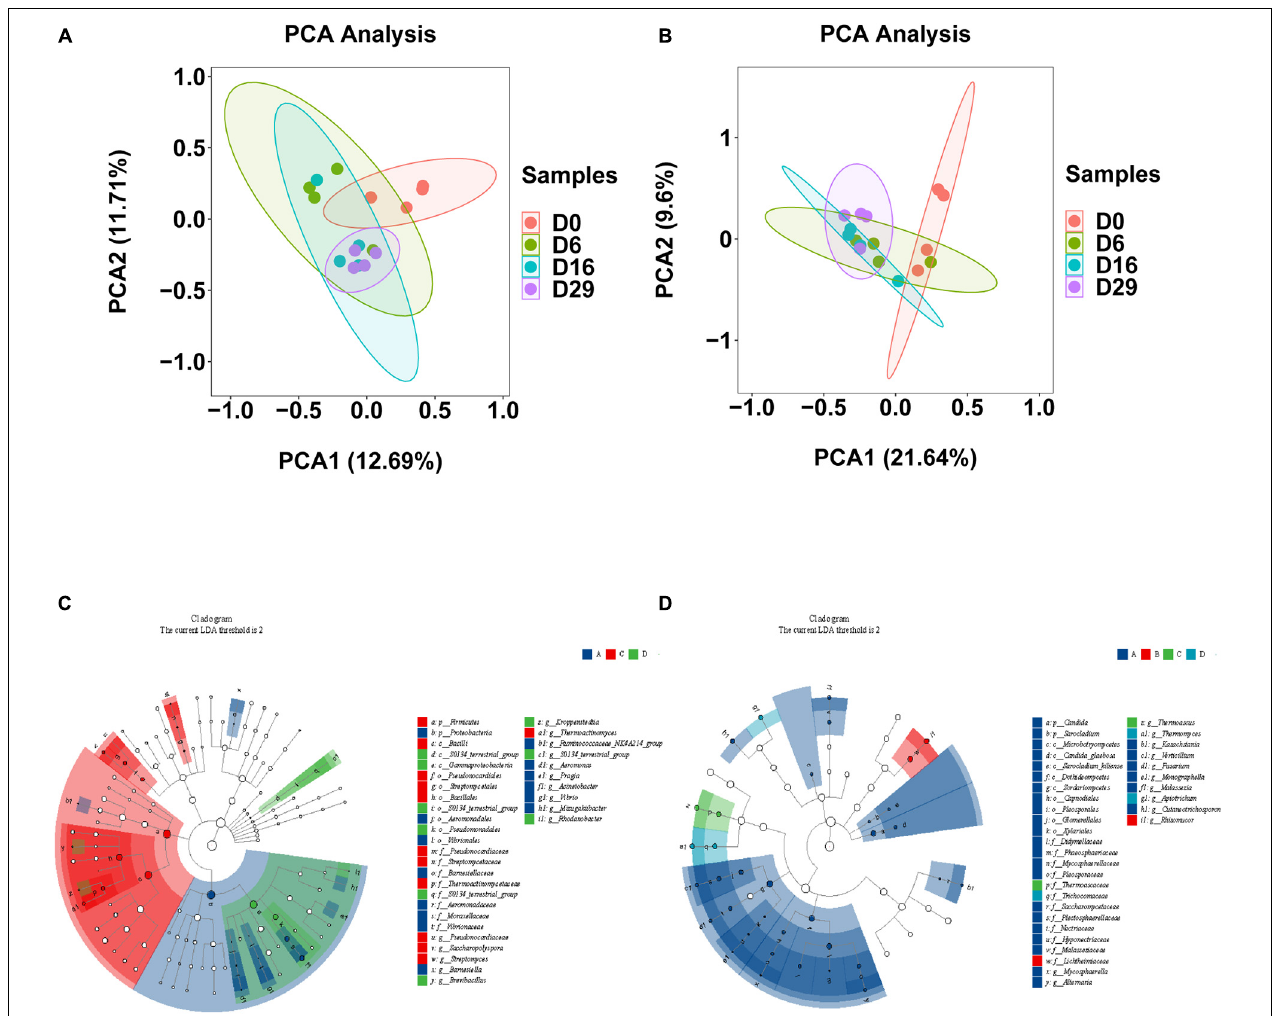
FIGURE 3 | Clustering analysis of bacteria (A) and the fungi (B) in different fermented samples (days 0, 6, 16 and 29)using principal component analysis. The differential bacteria (C) and fungi (D) in each time point of Daqu by using LEfSe analysis (LDA > 2, p < 0.05) (Four groups were set according to four time